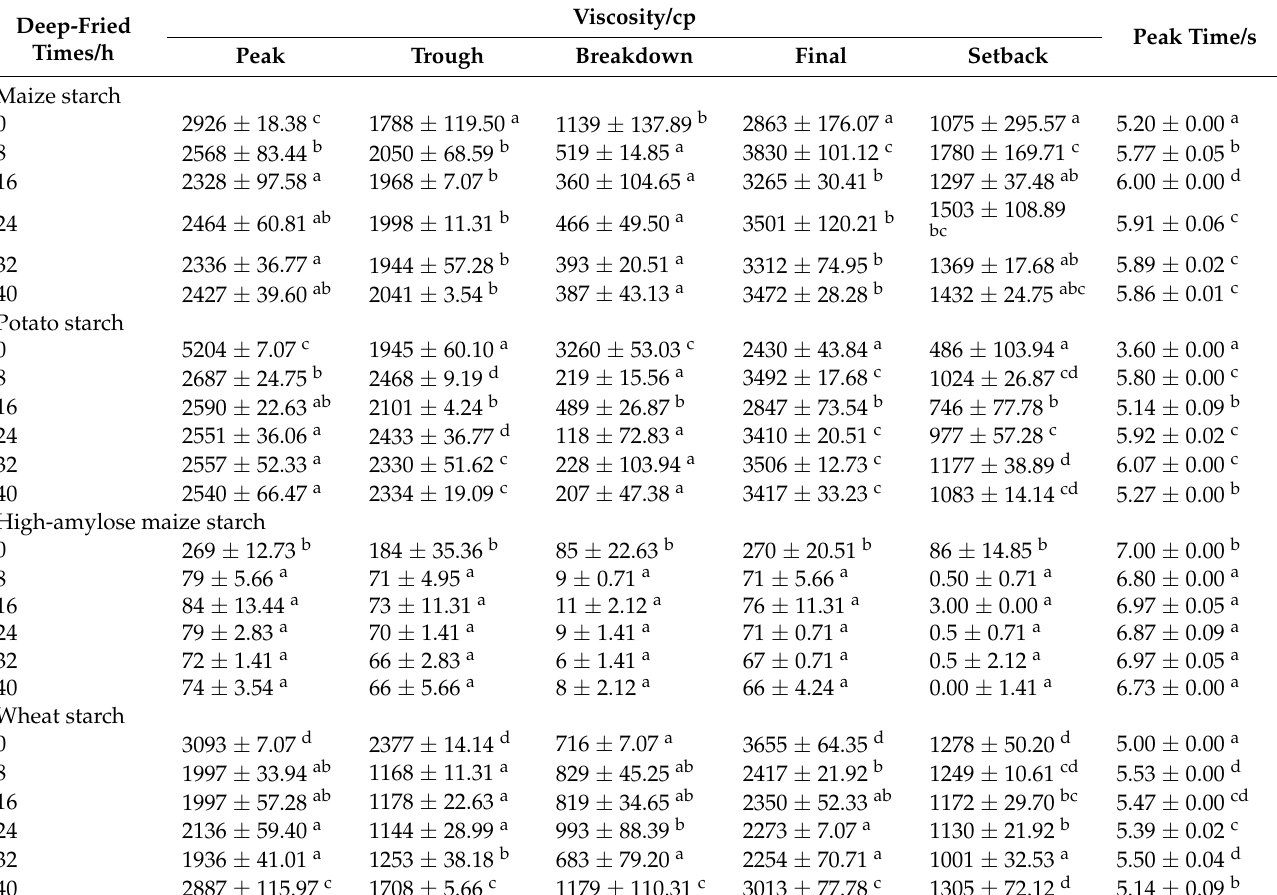
Table 2. Pasting properties of starch during the deep-frying process.